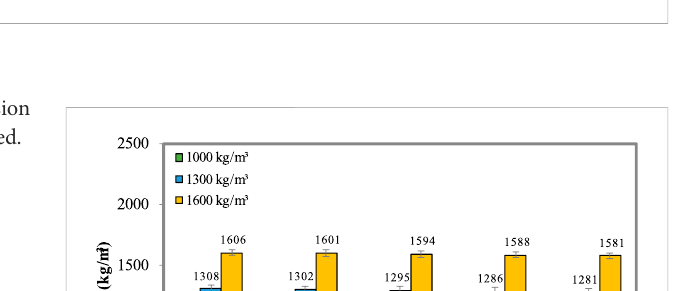
FIGURE 2 Slump fl ow of FC with varying weight fractions of SF.